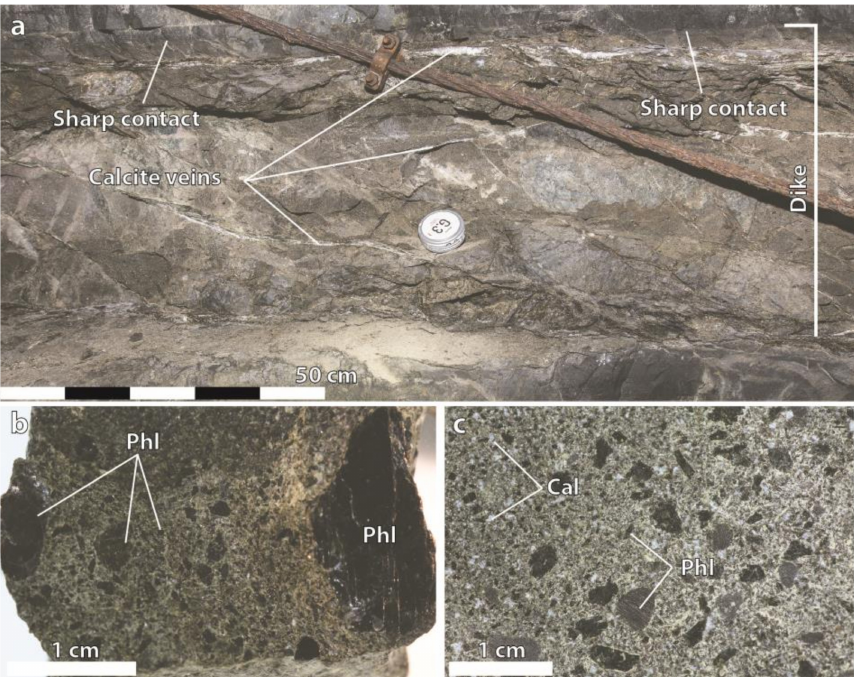
Figure 2. ( a ) Photo showing the contact relationships between the studied dyke and the host rock. Note the calcite veins crosscutting the dyke. ( b ) Hand specimen showing phlogopite phenocrysts up